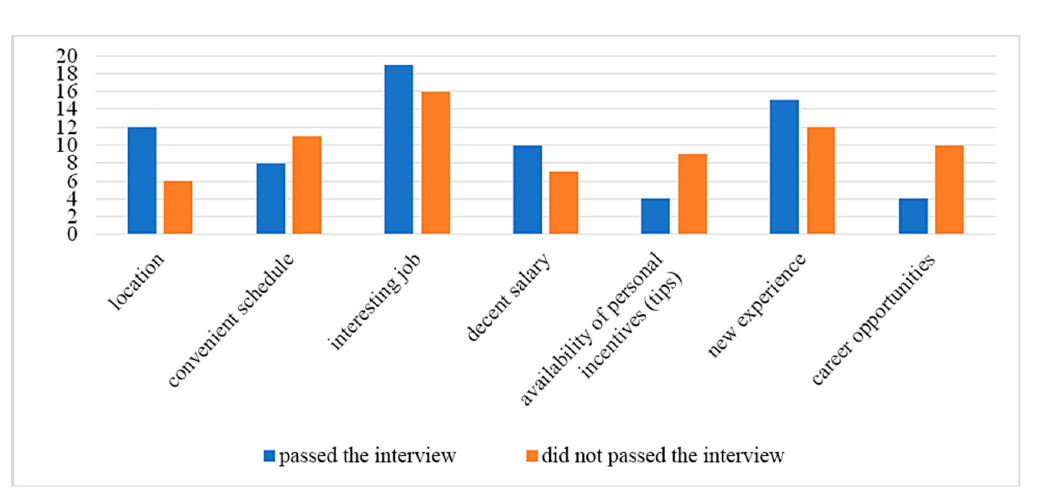
Figure 2. The summary of answers to the question: “Why did you decide to join our company?”.